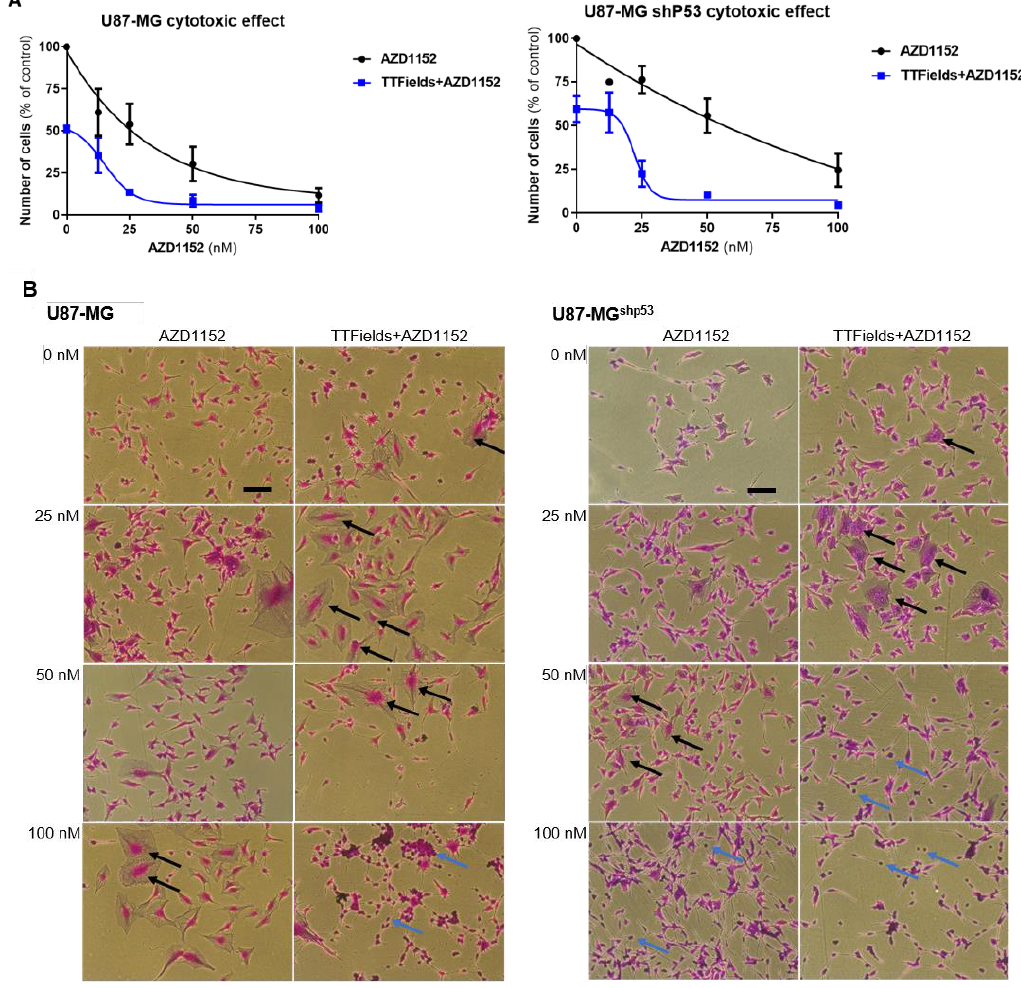
Figure 1. Cytotoxic effect in established cell lines. Increased efficacy of the concomitant treatment of AZD1152 and TTFields in U87-MG and U87-MG shp53 cells. Both glioma cell lines were treated with various AZD1152 concentrations and TTFields (200 kHz, 1.6 V/cm RMS) for 72 h. ( A ) The number of cells was determined at the end of treatment and is expressed as percentage of control. Data represent mean ± SD (N = 3 for AZD1152 and the line of TTFields + AZD is based on 2 independent experiments with 8 repeats for each concentration). For better comparison, data from both cell lines together are presented in Supplementary Figure S1. ( B ) Formation of multinuclear and pyknotic cells was detected under inverted microscope after staining with crystal violet. Black arrows mark multinuclear cells and blue arrows mark pyknotic cells. The size scale in the control group corresponds to 50 µm. Enlarged views are presented in Supplementary Figure S2.